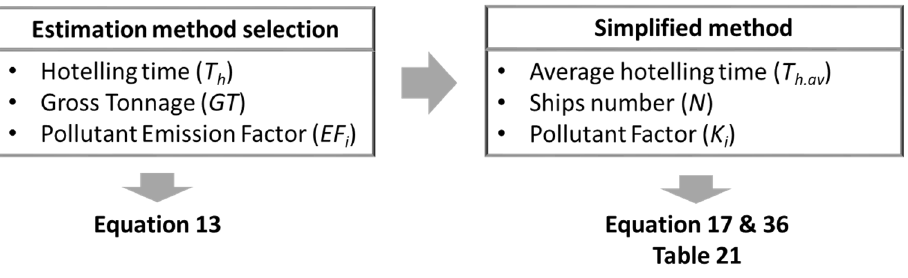
Figure 7. Summary of proposed methods.